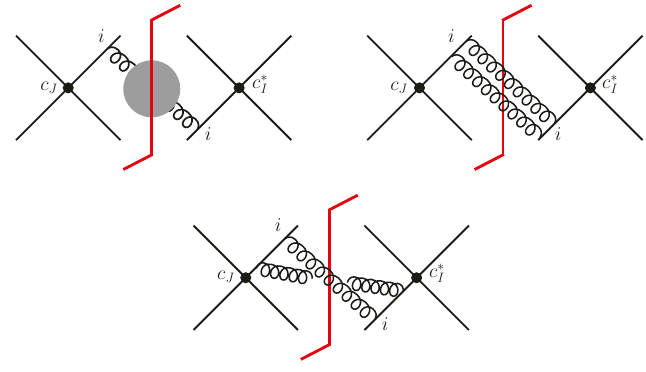
Figure 1 . One-Wilson-line double-real diagrams contributing to the NNLO soft function.